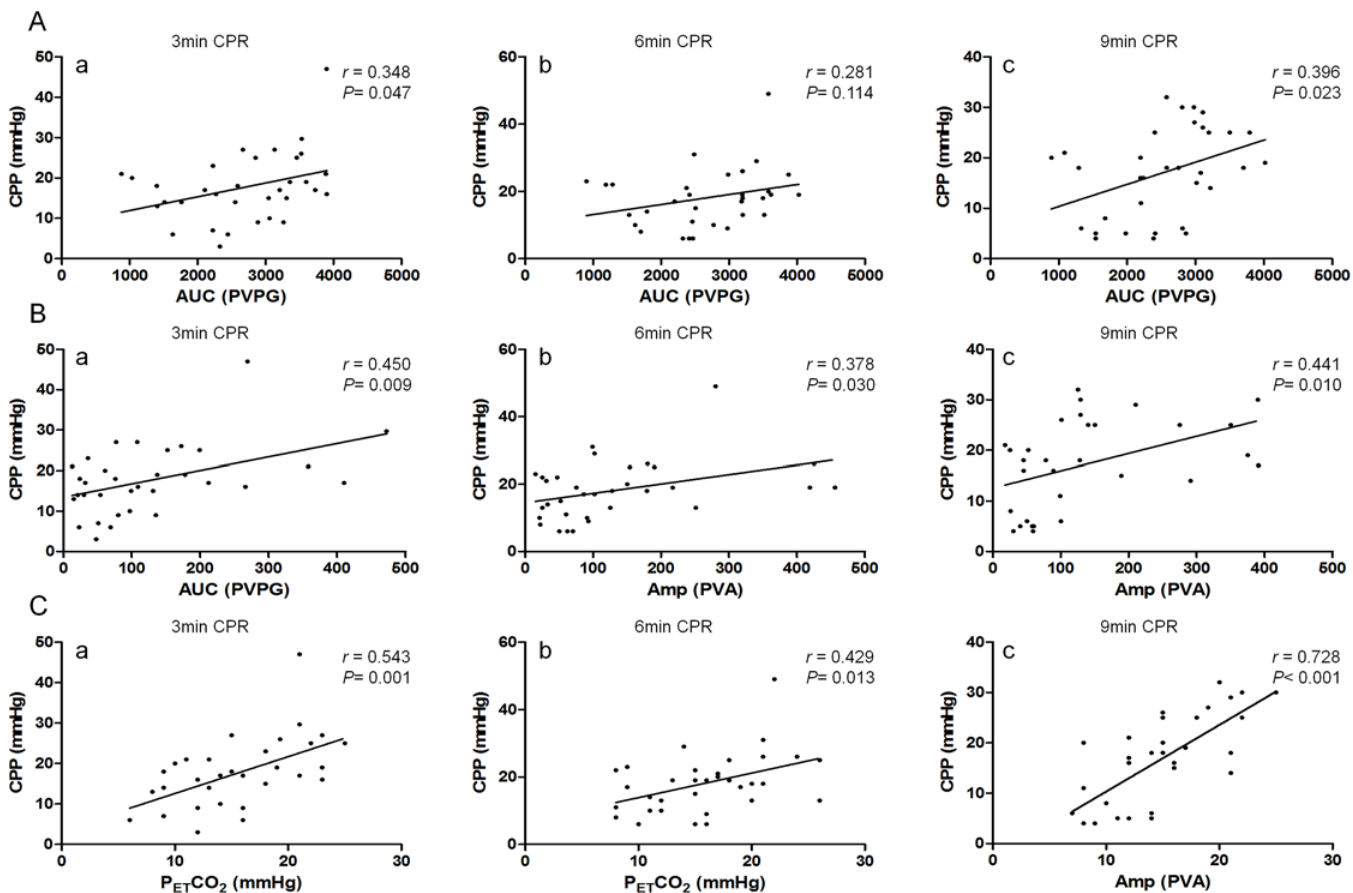
Fig 3. A. The correlation between AUC and CPP during different stages of CPR a. AUC was not correlated with CPP at the 3 rd minute of CPR ( r = 0.348, P = 0.047). b. At the 6 th minute of CPR, AUC was not correlated with CPP ( r = 0.281, P = 0.114). c. A correlation couldn ’ t be detected between AUC and CPP at the 9 th minute of CPR ( r = 0.396, P = 0.023). B. The correlation between Amp and CPP during different stages of CPR a. Amp was positively correlated with CPP at the 3 rd minute of CPR ( r = 0.450, P = 0.009). b. At the 6 th minute of CPR, Amp was not correlated with CPP ( r = 0.378, P = 0.030). c. A positive correlation could be detected between Amp and CPP at the 9 th minute of CPR ( r = 0.441, P = 0.010). C. The correlation between P ET CO 2 and CPP during different stages of CPR a. P ET CO 2 was positively correlated with CPP at the 3 rd minute of CPR ( r = 0.543, P = 0.001). b. At the 6 th minute of CPR, P ET CO 2 was not correlated with CPP ( r = 0.429, P = 0.013). c. P ET CO 2 was positively correlated with CPP at the 9 th minute of CPR ( r = 0.728, P <